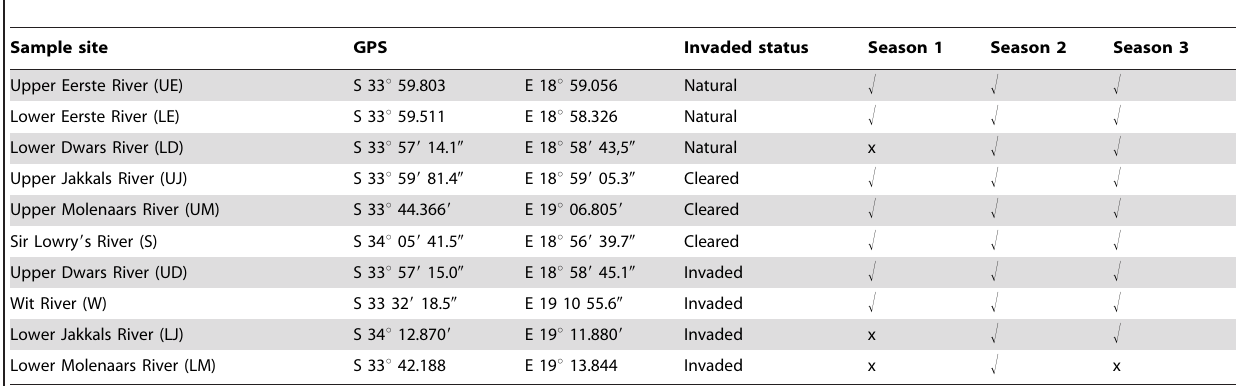
Table 1. Summary of the sample sites indicating the location, position within the catchment, invasive status of the site and the time when the sites were sampled, adapted form Reinecke et al. 2007.